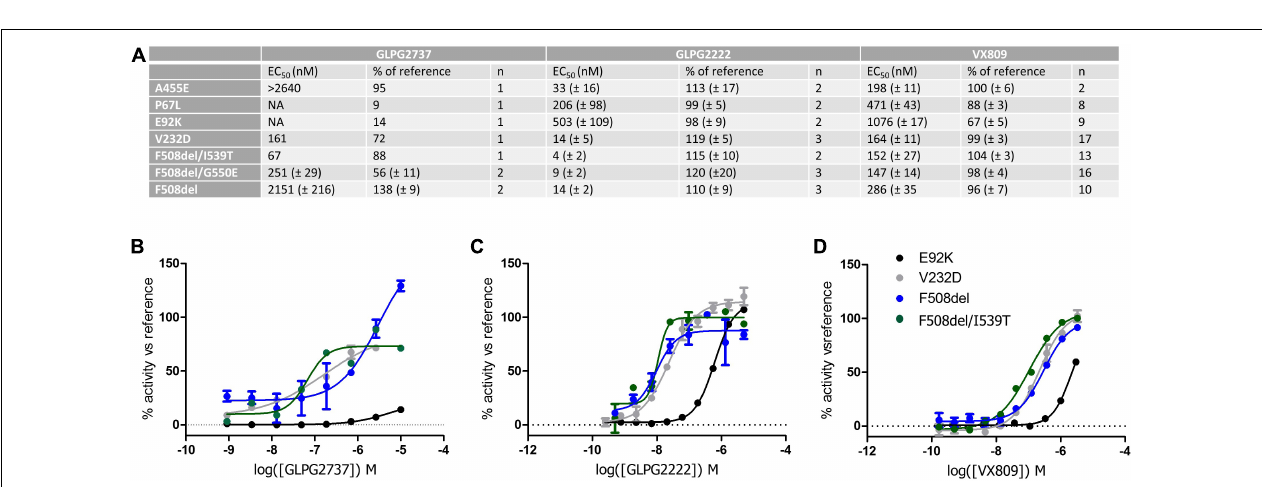
FIGURE 6 | Effects of GLPG2737 on normal human bronchial epithelial cells (NHBE) and HEK cells expressing WT CFTR. GLPG2737 dose response effect on WT CFTR activity in HEK293 cells after 24 h stimulation (A) or acute incubation (B) and activation using 100 nM FSK. C. GLPG2737 dose response effect on CFTR activity in NHBE cells after acute addition (0.3 µ M forskolin) (tested in duplicate at each concentration for panels A–C ). (D) NHBE treated for 24 h with 1 µ M GLPG2737 or DMSO (control), CFTR channel was activated with either 0.1 µ M or 0.3 µ M forskolin, measured I sc shown in gray. After forskolin treatment, potentiator GLPG2451 (10 µ M) was added to the GLPG2737 treated cells, further increase in I sc shown in white bar. n = 2–3 for each condition, p < 0.01 when comparing GLPG2737 with DMSO treated cells after forskolin treatment (all cases) and p > 0.05 when comparing GLPG2737 with DMSO treated cells after forskolin + potentiator treatment (all cases). (E) Representation of the average raw traces represented in panel A (0.3 µ M forskolin). Light gray line represents cells without forskolin. Green line represents GLPG2737 treated cells. Black line represents cells treated only with forskolin.